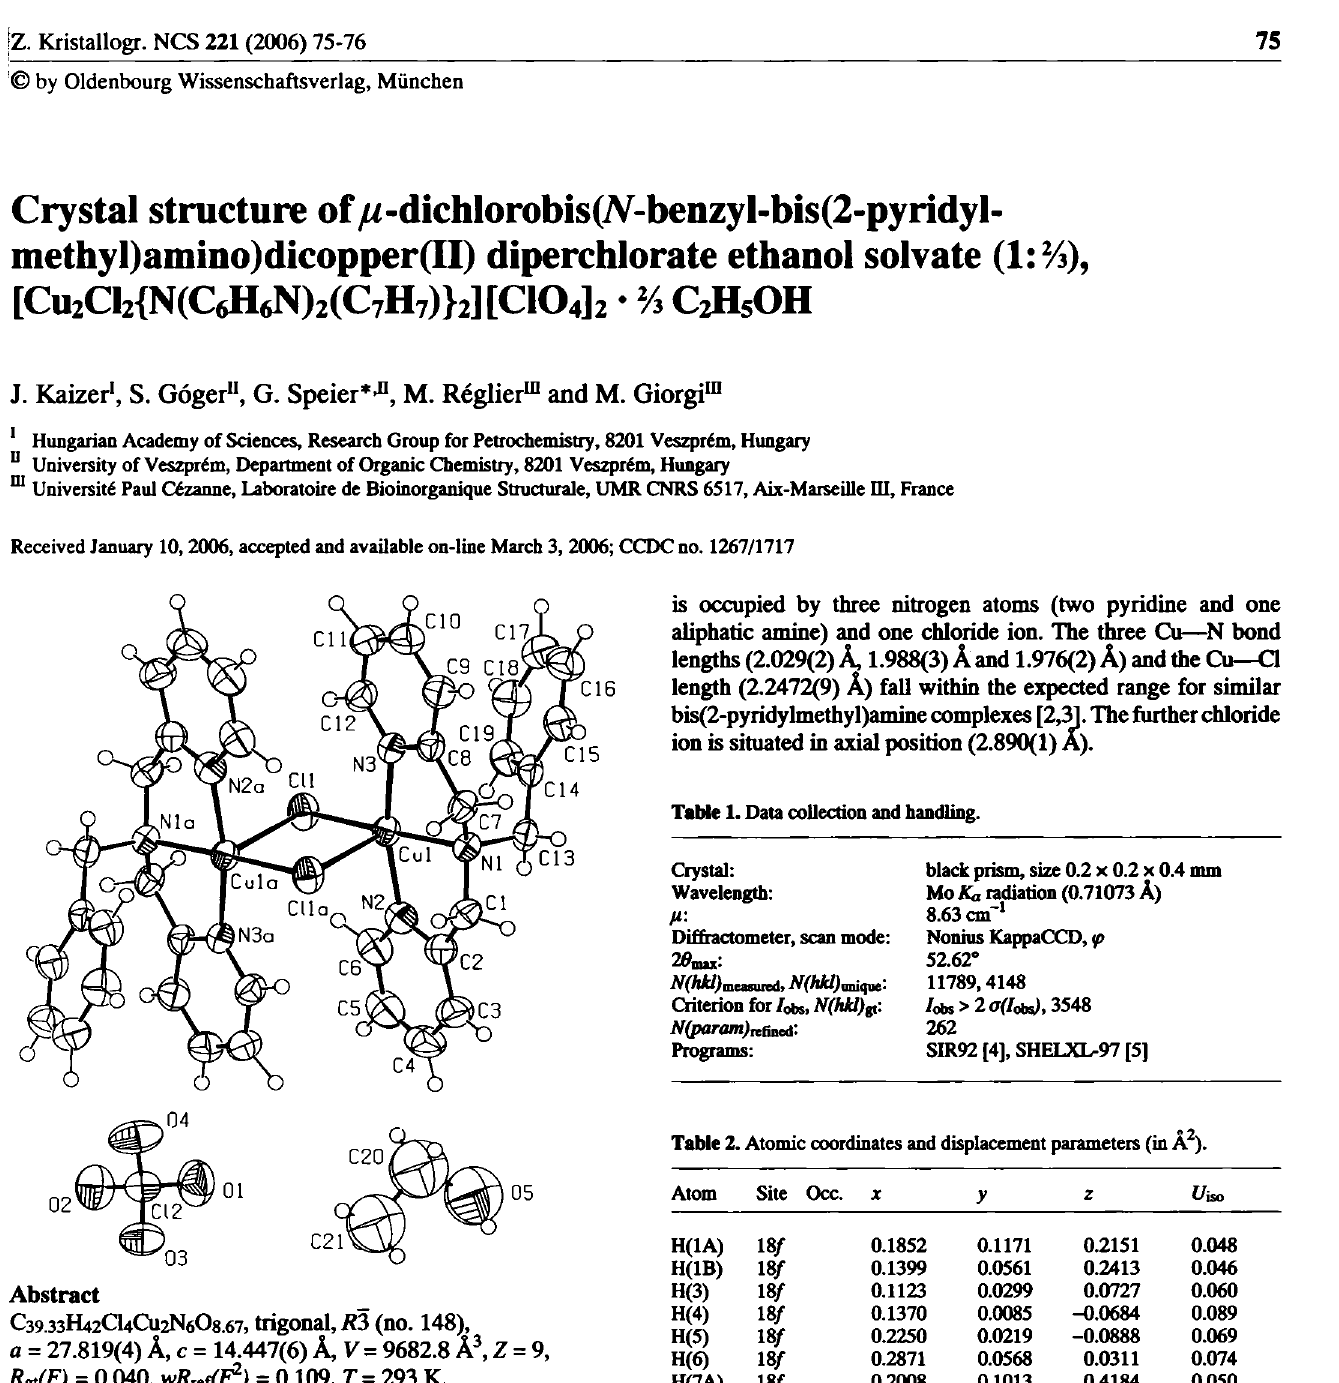
Table 2. Atomic coordinates and displacement parameters (in A